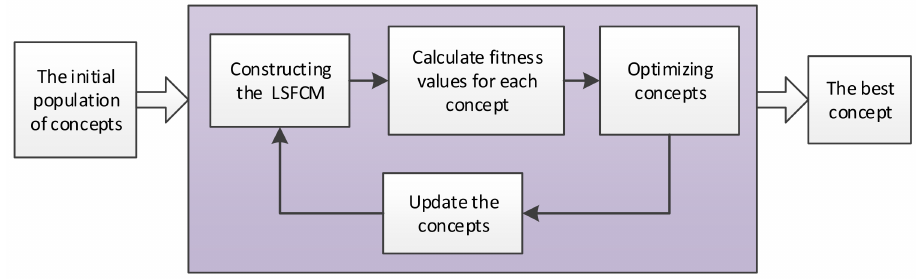
Figure 3. Migration of